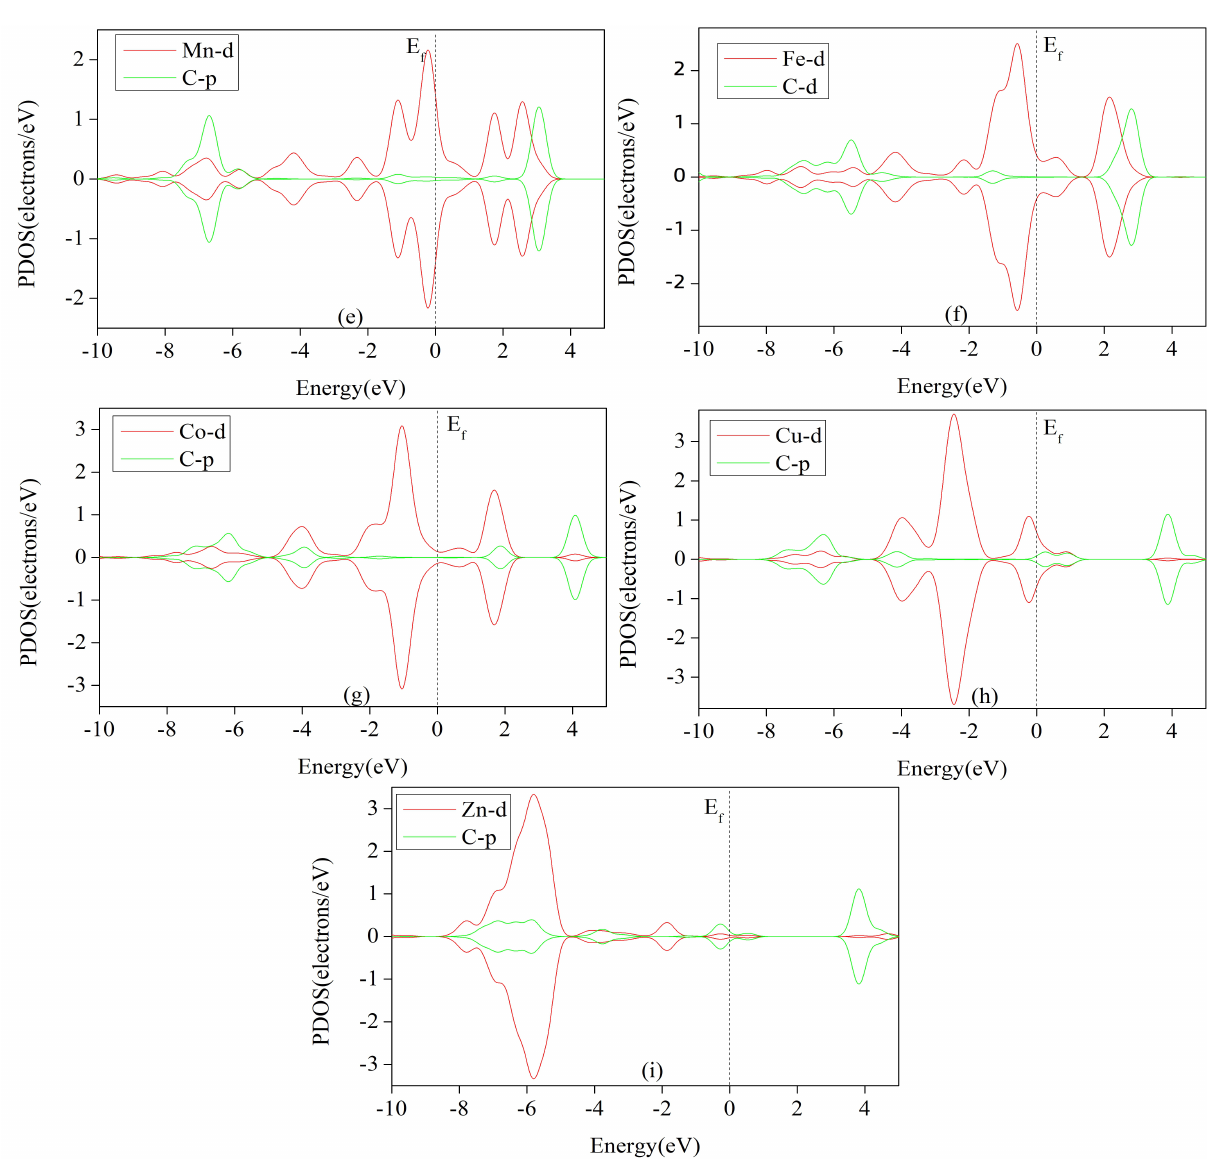
Figure 10. Predicted partial density of states of *OCHOH adsorbed on Sc, Ti, V, and Cr ( a – d ). *CO adsorbs on Mn ( e ), *CHO adsorbs on Fe ( f ), and *COOH adsorbs on Co, Cu, and Zn ( g – i ). The dashed lines indicate Fermi levels. The red, blue and green wires represent the 3D orbitals of metallic atoms, the 2P orbitals of the oxygen atoms and the 2P orbitals of the carbon atoms,